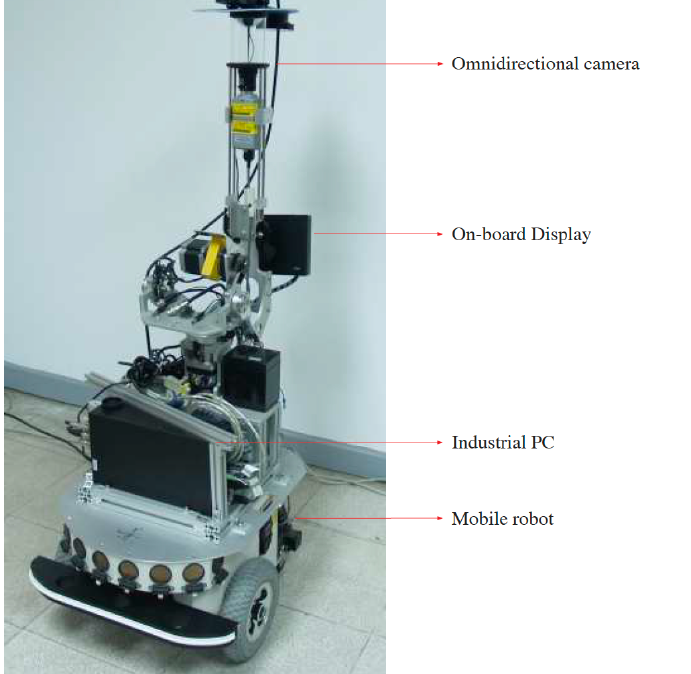
Figure 9. A mobile robot equipped with an omnidirectional camera is used in this work.